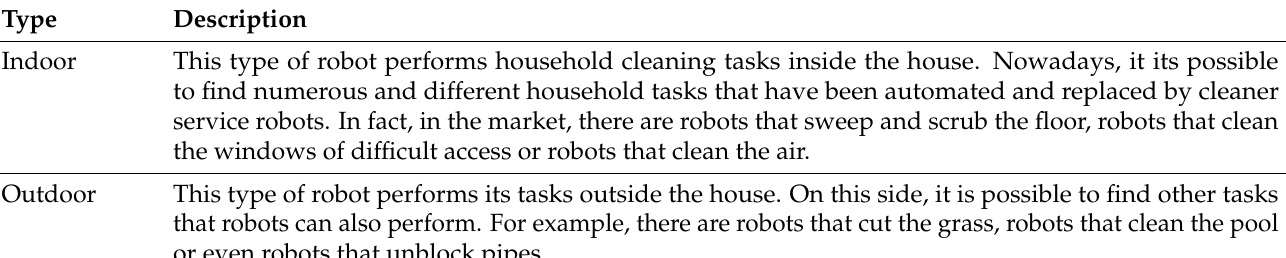
Table 3. Classification of personal cleaning robots according to the scenario.